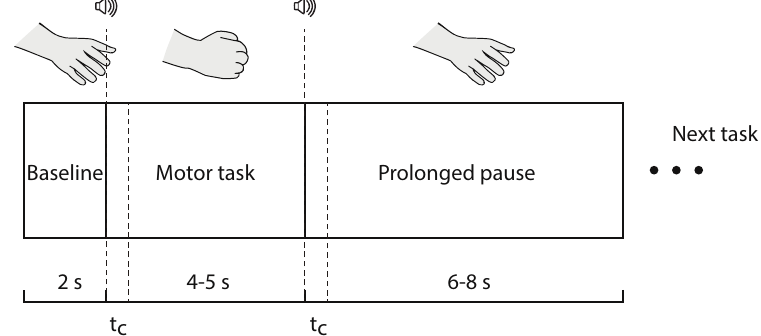
Figure 2. Timeline of an individual motor task. Here, t c denotes the duration of audio